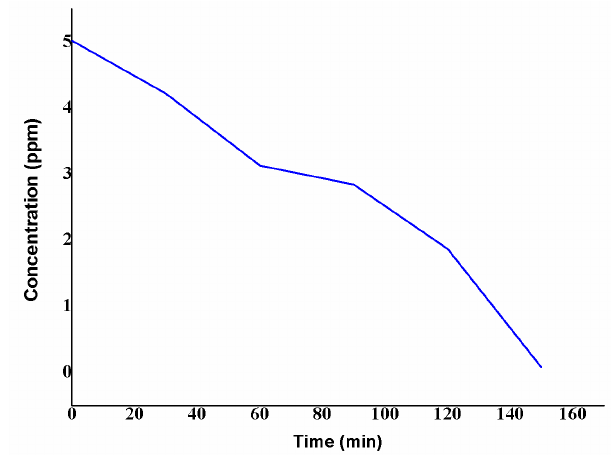
Figure 7. Atomic absorption spectroscopy analysis of zinc acetate in the nanoparticle-forming solution.